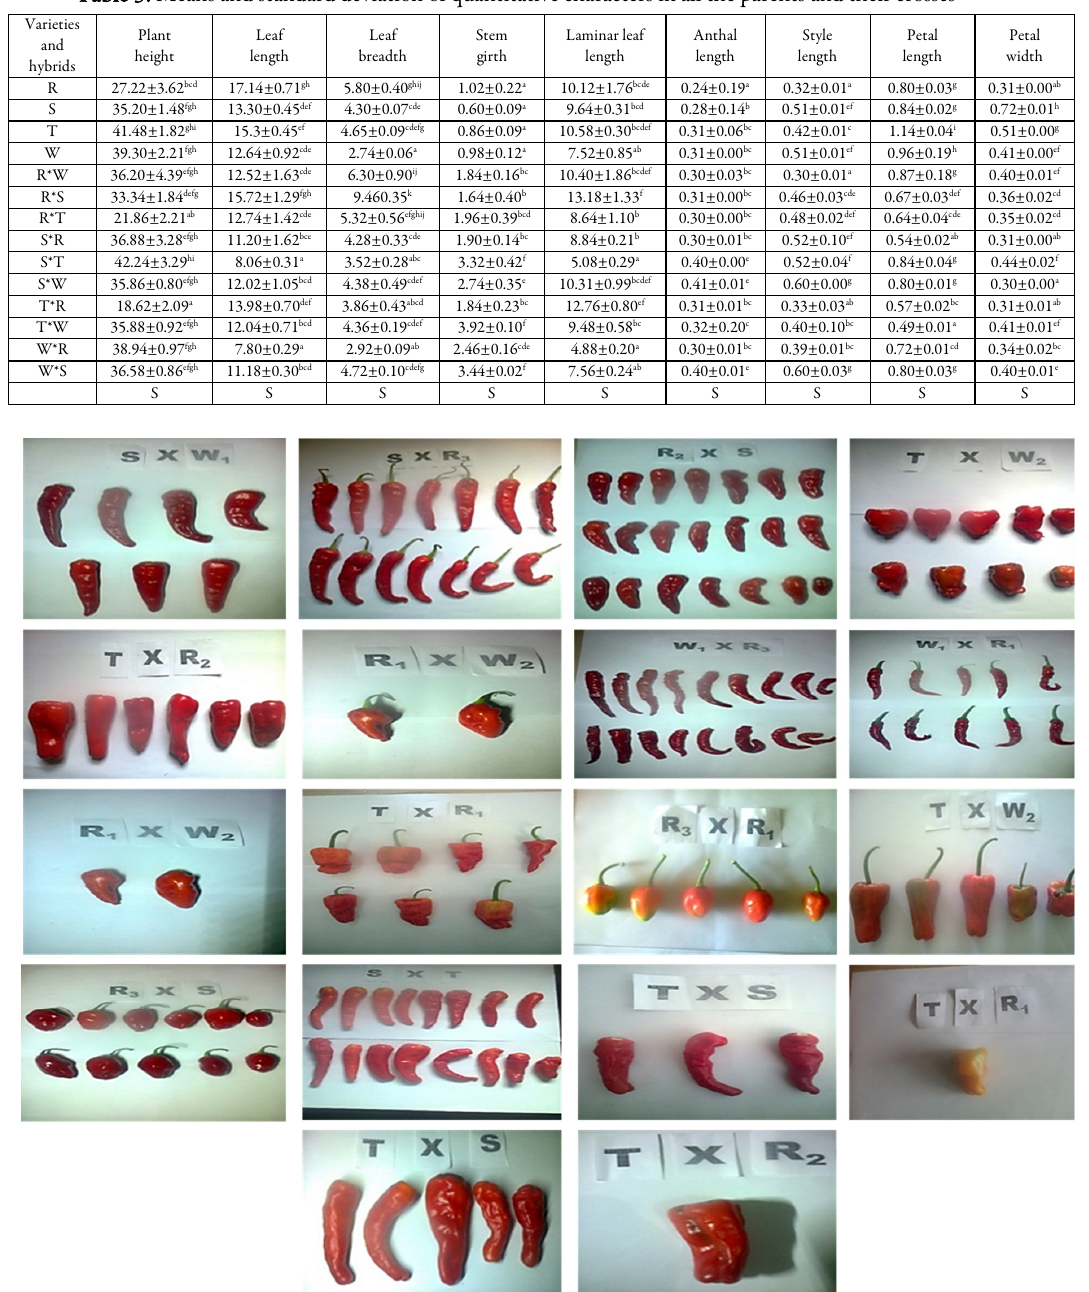
Table 3. Means and standard deviation of quantitative characters in all the parents and their crosses